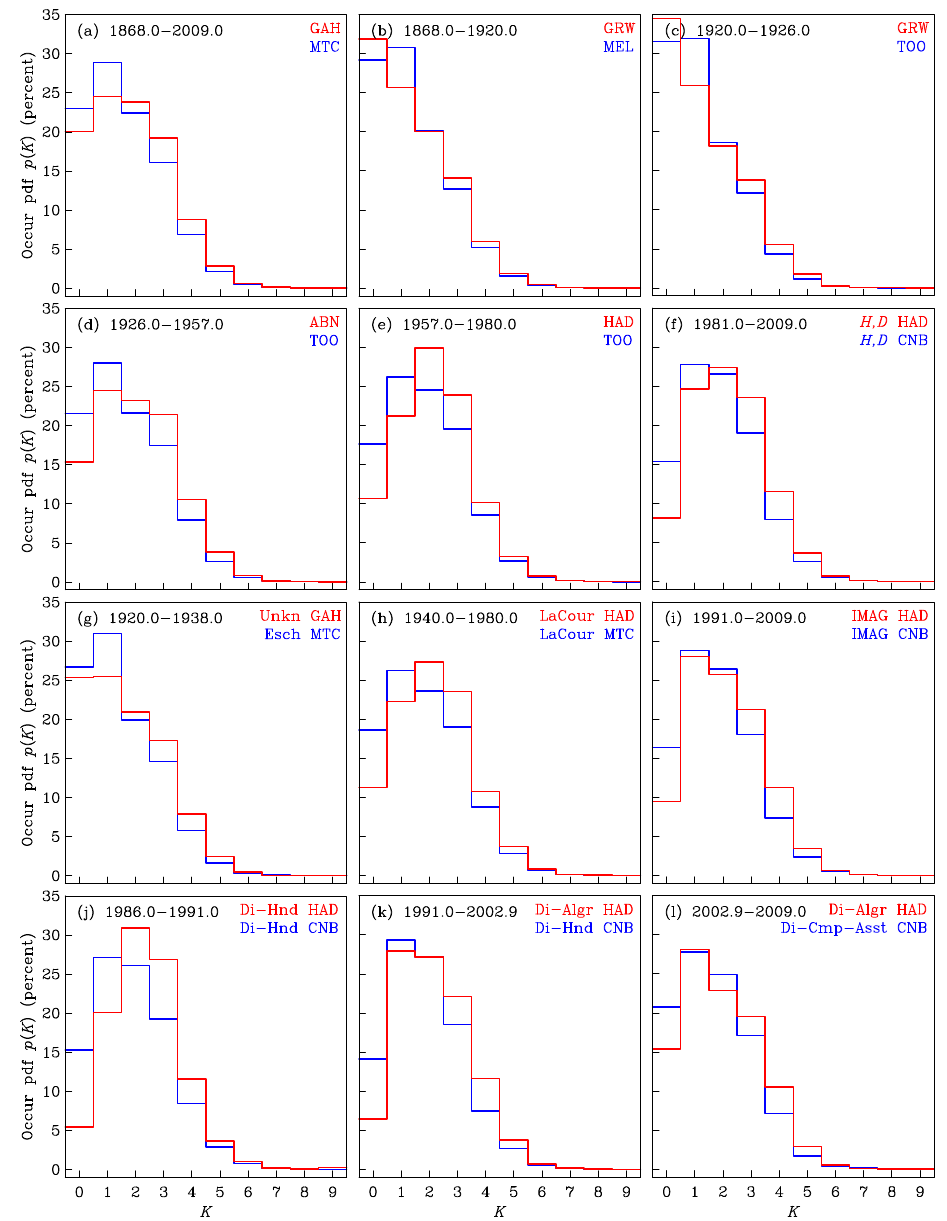
Fig. 1. Probability density functions p ( K ) for K indices for British (red) and Australian (blue) observatories: (a) 1868.0-2009.0 for observatory groups GAH and MTC, (b-f) the 5 subset durations of time corresponding to the continuous operation of a British-Australian pair of observatories, (g) continuous operation of an unknown type of variometer in Britain and an Eschenhagen variometer in Australia, (h) continuous operation of La Cour variometers in both Britain and Australia, (i) Intermagnet-certified digital data production, (j) hand-scaling for K -value estimation in Britain and Australia using printed digital magnetograms, (k) K -value estimation in Britain by a computer-algorithm and using digital data and in Australia by hand-scaling using digital data, (l) K -value estimation in Britain by a computer-algorithm and using digital data and in Australia by computer-assistance using digital data. Compare with Fig. 3.